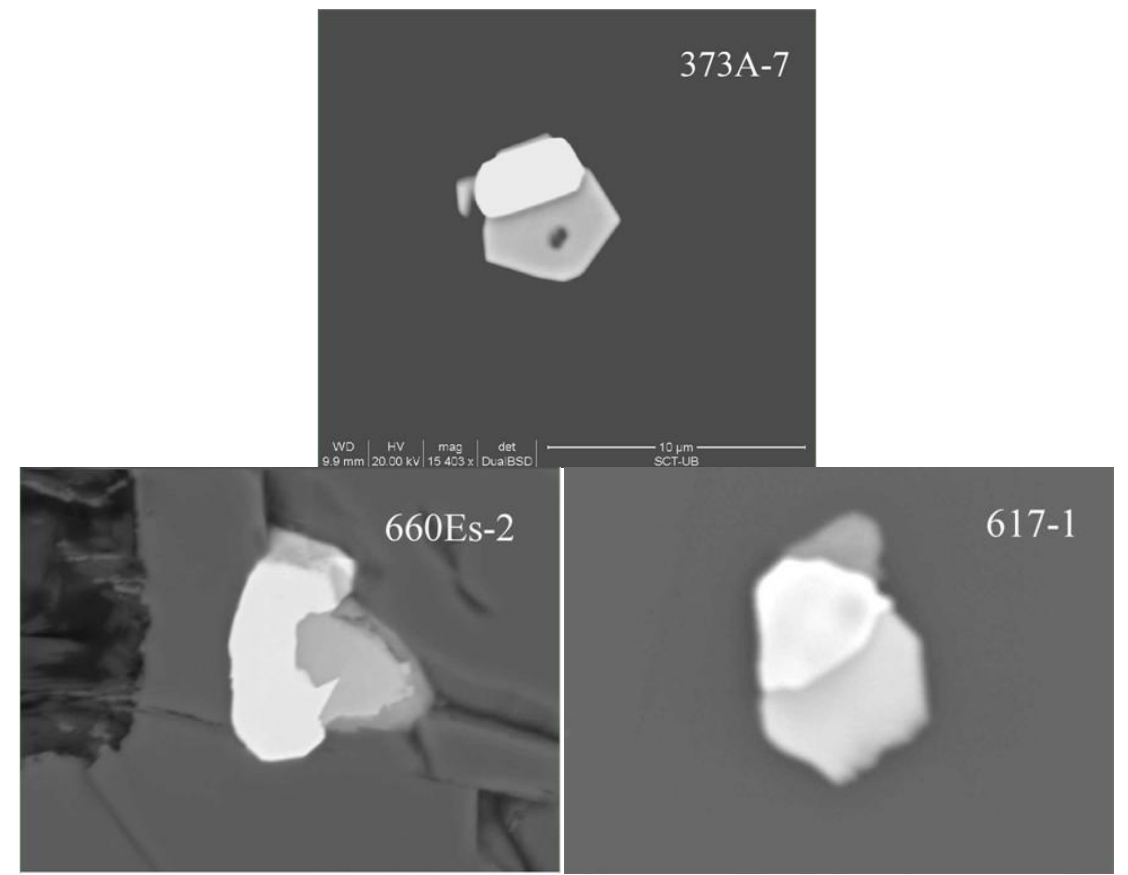
Figure 11. Paragenetic assemblages of Ru-Os-Ir PGM in the CHR-2 chromitite (BSE images). 373A-7: Euhedral composite grain of erlichmanite + iridosmine + pentlandite (dark crystal in the sulfide), included in chromite 2. 660Es-2: Partially altered composite grain of laurite + irarsite in fractured chromite 2. 617-1: Composite grain consisting of irarsite (low) + Os-alloy (middle) + laurite (upper) included in chromite 2.